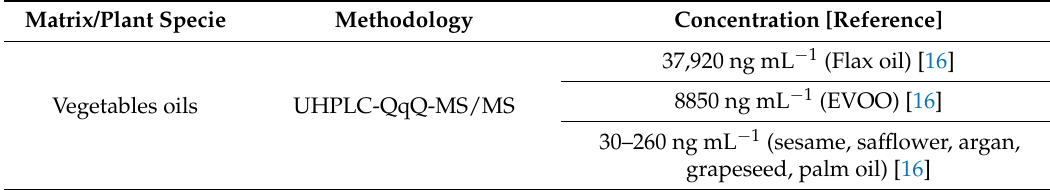
Table 2. Natural occurrence of phytofurans in vegetables